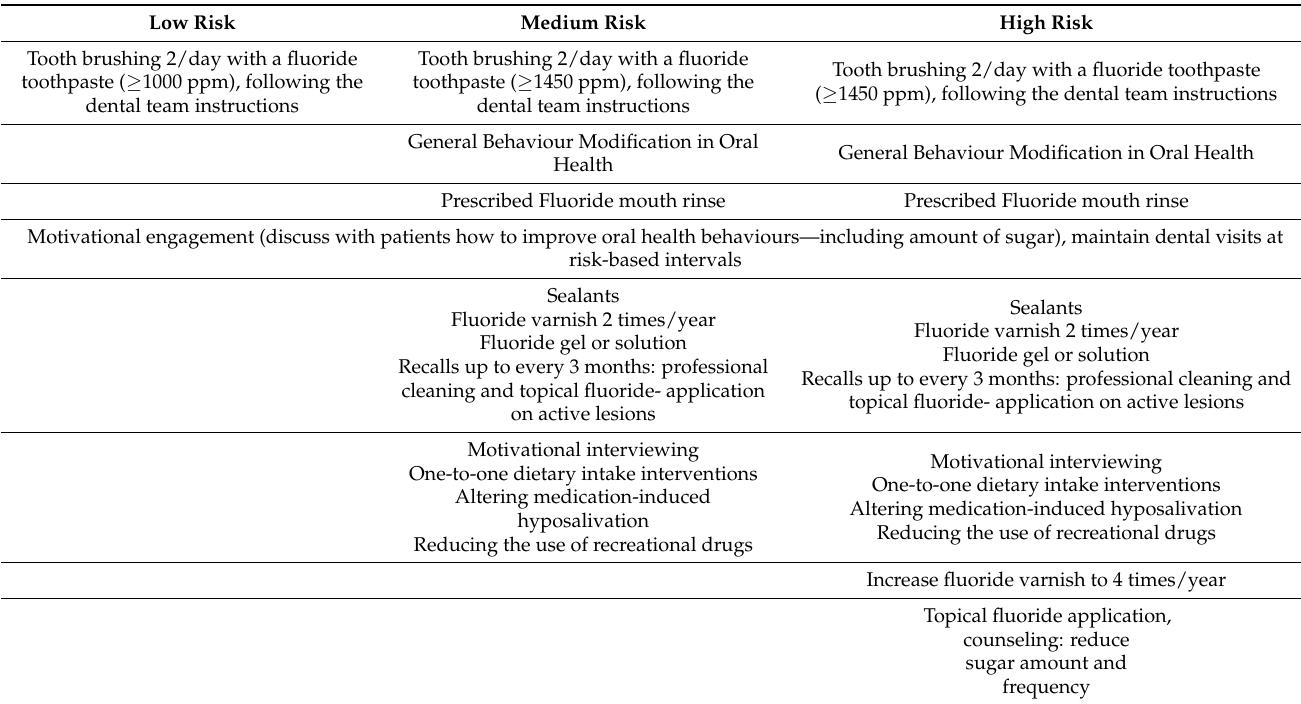
Table 1. Managing a patient’s risk factors (from ICCMS TM